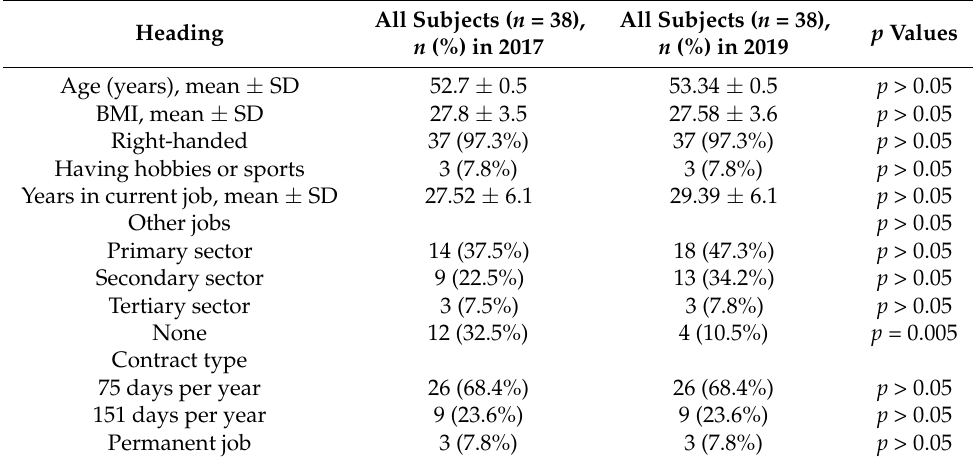
Table 2. Individual characteristics of study